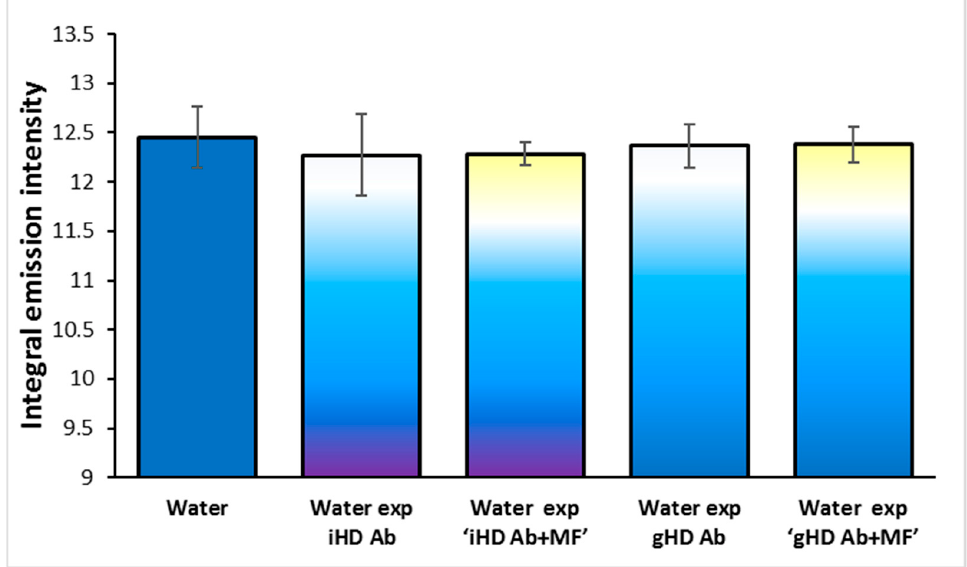
Figure 8. Integral intensity of emission in the range of 470–2000 cm − 1 of samples of water and water exposed to iHD Ab and gHD Ab, without and with their preliminary treatment with a magnetic field. In sample labels, ‘exp’ means ‘exposed to’, ‘+MF’ means ‘treated with a magnetic field’. Data are presented as mean ± SD.